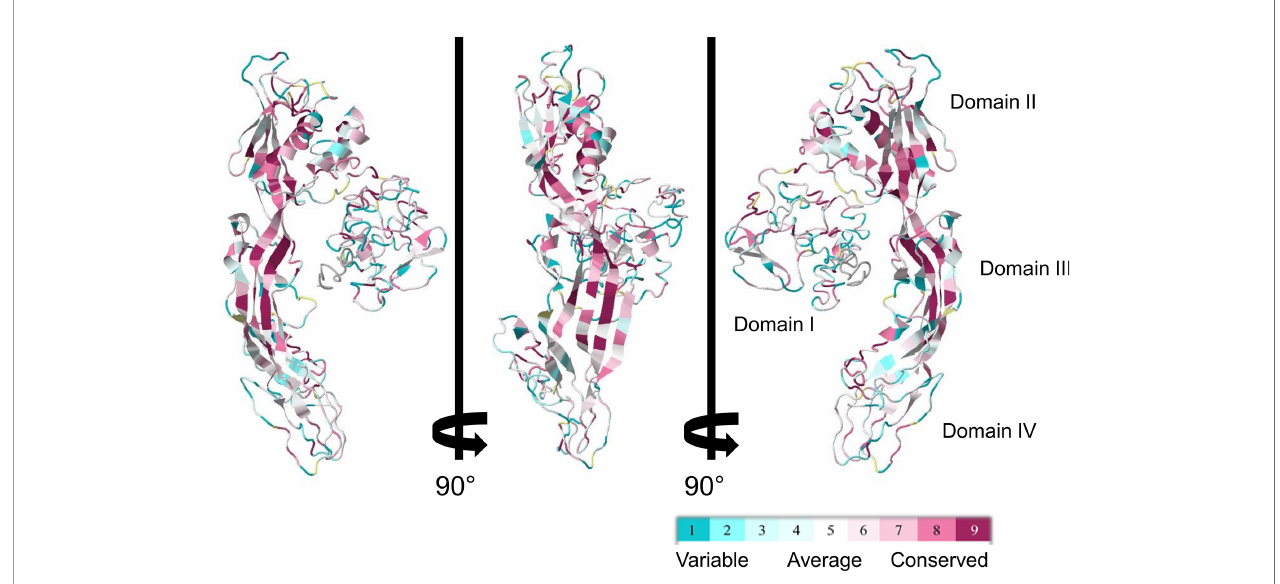
FIGURE 5 | ConSurf sequence conservation score of biomphalysin proteins. ConSurf image was generated using alignment of all 23 biomphalysin proteins and by plotting alignment scores on the predicted structure of biomphalysin 1. Variable residues are shown in cyan while the most conserved ones are in dark red. Images are rotated 90° around the y